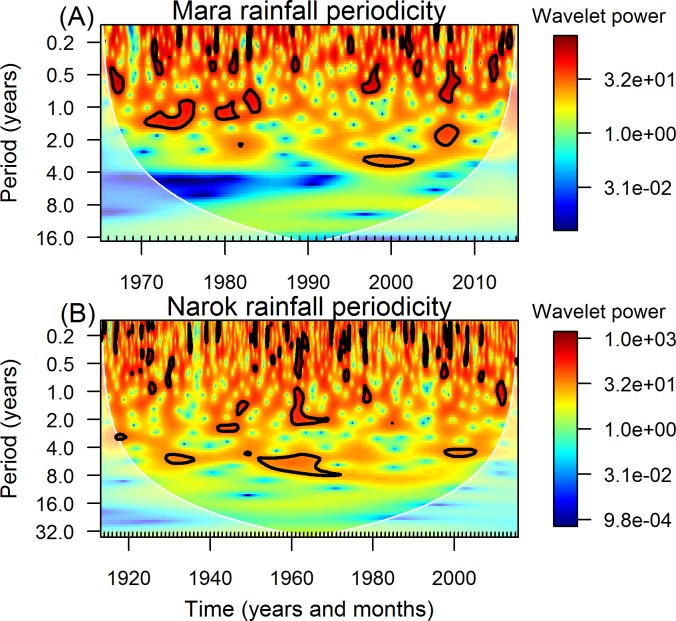
Periodicity in monthly rainfall derived from wavelet analysis.(A) Rainfall recordings in the Mara were derived from 15 gauges (Eq 3 in S1 Text) during the period 1965–2015. (B) Rainfall in Narok Town in Kenya was recorded during 1913–2015. The wavelet power spectrum (bias-corrected and normalized by the variance) for varying rainfall cycle periods is given for each month and year. Areas of high power are indicated in warm colours (red), whereas areas of low power are indicated in cold colours (blue). The semi-transparent area represents the cone of influence, where edge effects become important due to padding with zeros at the end of the time series. The power in this region is reduced. Significantly higher wavelet power spectra than expected under a red-noise process AR(1) (lag ‒ 1 = 0.05 for the Mara and lag ‒ 1 = 0.16 for Narok Town) are encircled by black lines.